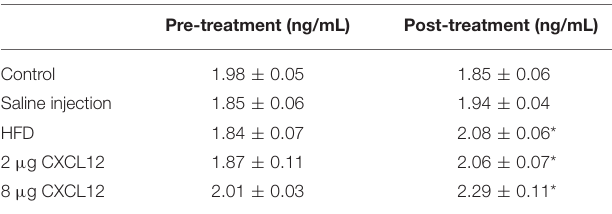
TABLE 1 | Average circulating levels of CXCL12 in dams pre- and